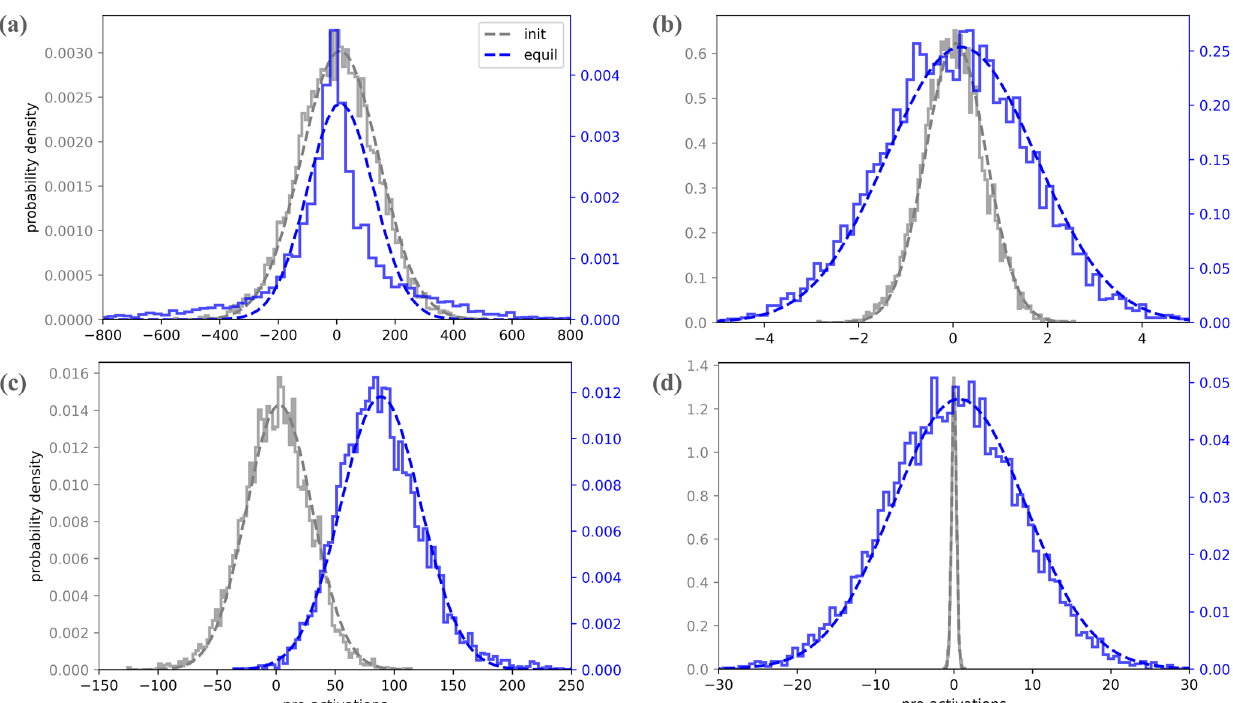
from the initial one in either or both its mean and variance, a signature of feature learning. Generally, we fi nd that Gaussianity increases with the depth of the layer (i.e. downstream layers are more Gaussian than upstream layers), and with the index of the eigenvector, we project on (e.g. here projection on the 10th eigen- vector is more Gaussian than on the 1st eigenvector). More details can be found in SupplementaryMaterial(6.3),wherewealsoshowthatcorrelationsaresmallacross different layers and across channels within each layer, thus justifying neglecting these in our